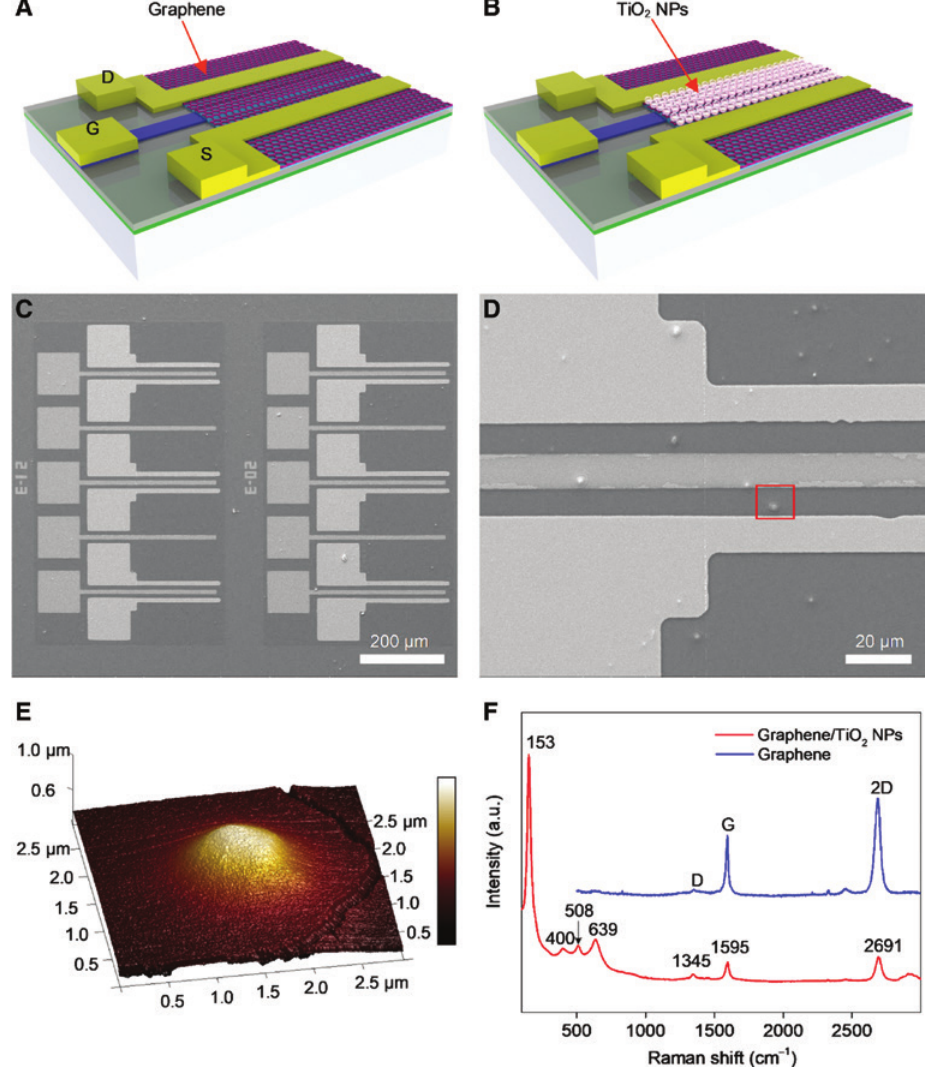
) nanoparticles (NPs) decorated buried-gate graphene field-effect transistors (GFETs). Figure 1: Titanium dioxide (TiO 2 (A) and (B) Buried-gate GFETs before and after the decoration of TiO NPs on the surface of graphene. (C) Scanning electron microscopy 2 micro-image of a 2 × 5 array of TiO NPs decorated GFETs. (D) Zoomed-in details of the graphene/TiO NPs conductive channel. (E) Atomic 2 2 force microscopy micro-image of agglomerated TiO NPs (marked in red box in Figure 1D). (F) Typical Raman spectra of the GFETs with (red 2 line) and without (blue line) TiO 2